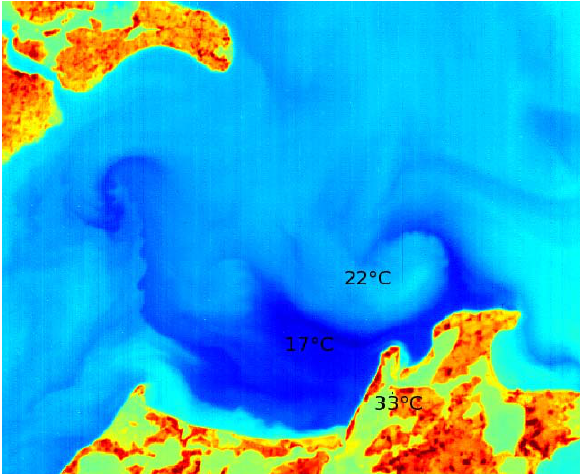
Figure 7: Sea surface temperatures on the Southern Baltic Sea, (10th July